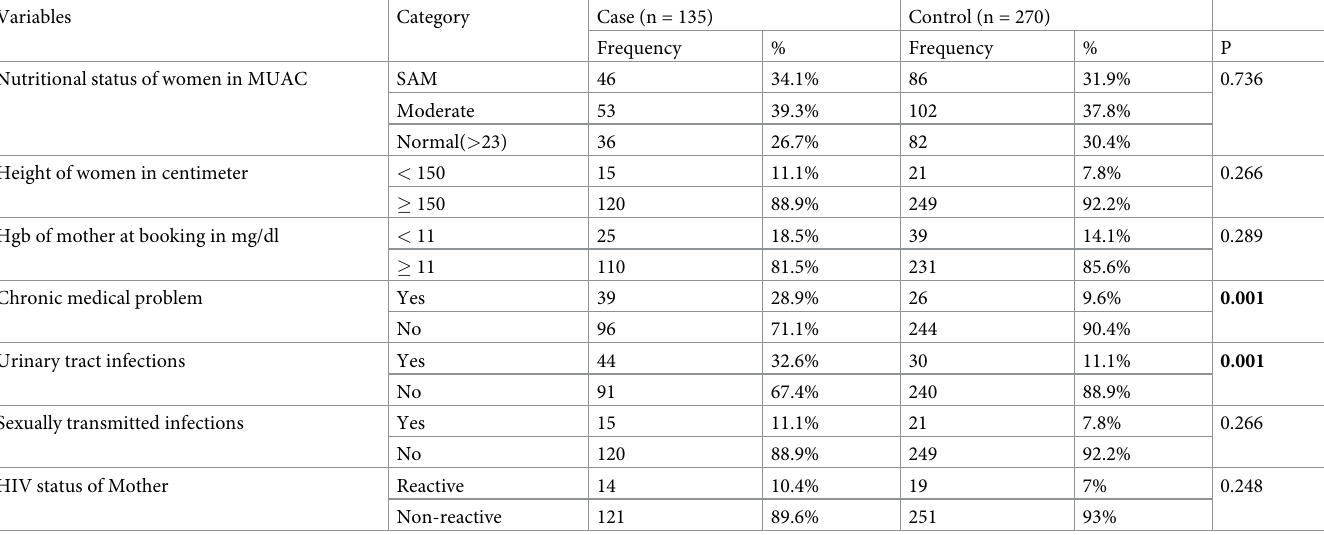
Table 3. Medical problems related characteristics of mothers who gave birth at public hospitals in Sidama region, Southeast Ethiopia, 2020 (n = 405). Variables